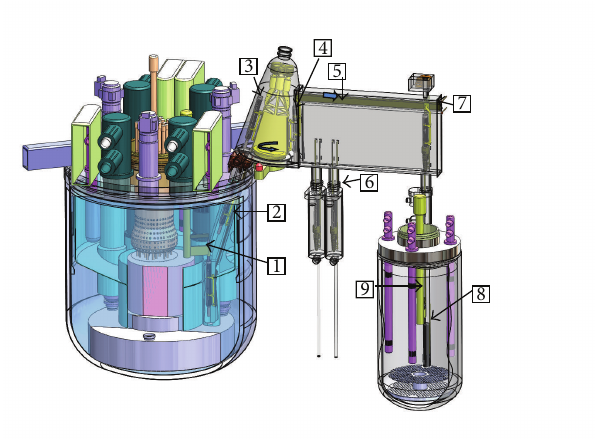
Figure 7: Kinematics for the evacuation of an irradiated